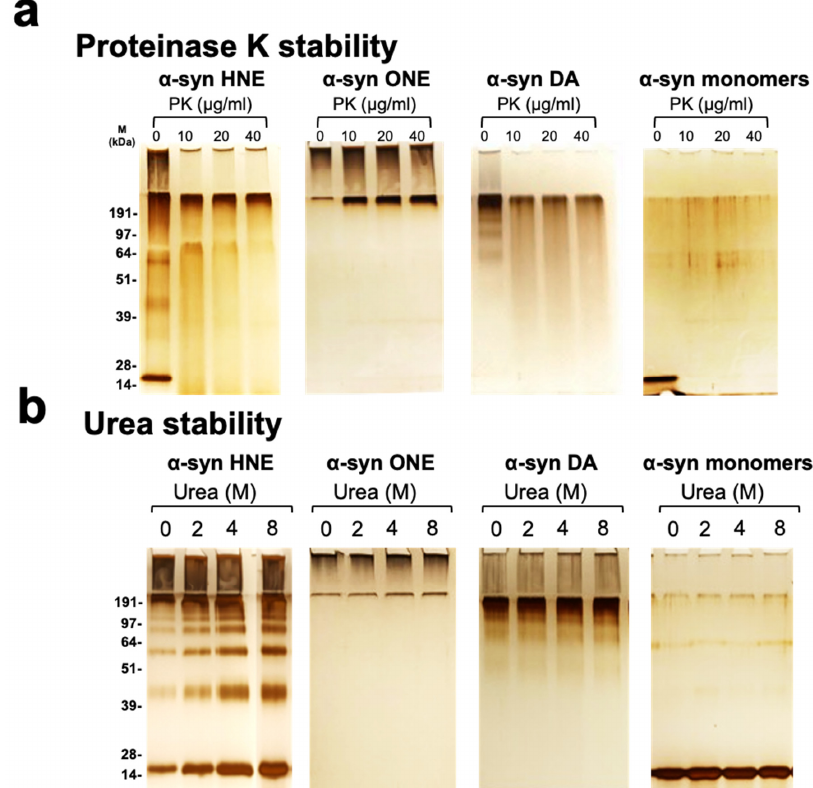
Figure 3. Stability of oligomers. ( a ) α-Syn monomers and different oligomers preparations were incubated alone (0 ug/mL) or with increasing concentrations of proteinase K (10, 20, or 40 μg/mL) at 37 °C for 30 min and loaded onto the gel and silver-stained. ( b ) α-Syn monomers and different oligomer preparations were incubated alone (0 M) or with 2, 4, or 8 M urea for 1 h at room temperature and loaded onto gel and silver-stained.